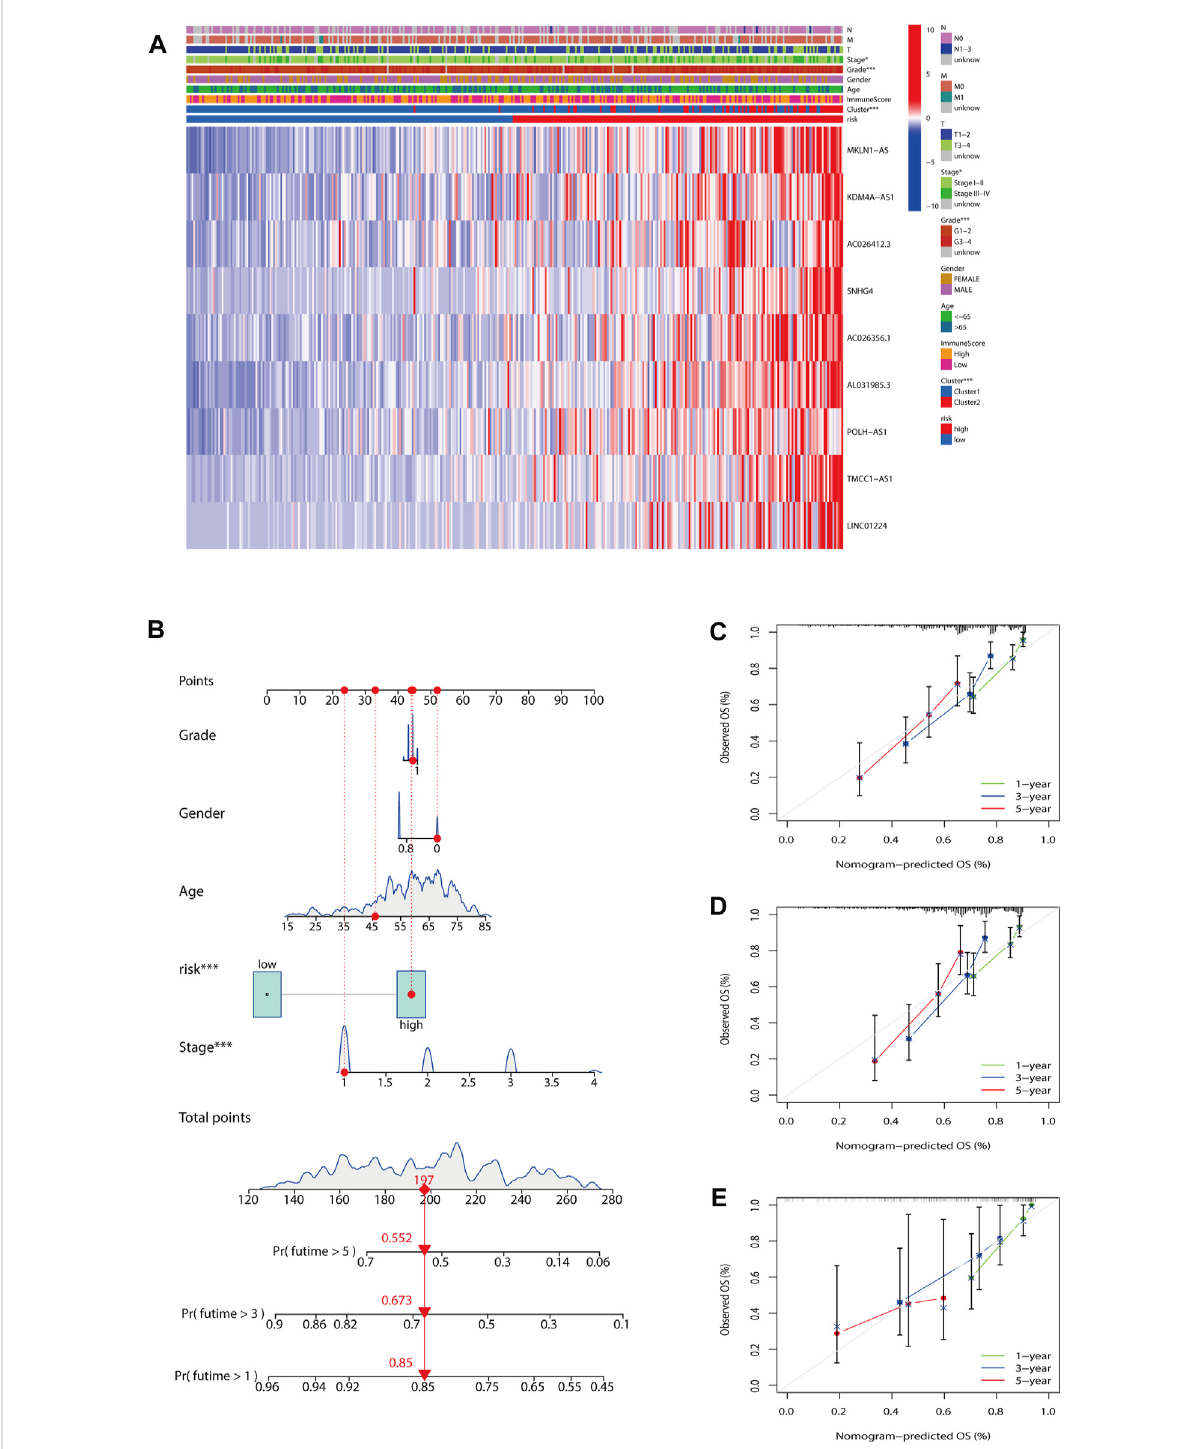
FIGURE 8 Establishment of nomogram. (A) The heatmap included the expression of nine m7G-LPS, clustering characteristics, immune score, and TMN stage. (B) Nomogrambasedongrade,gender,age,andriskscore. (C – E) Calibrationcurvesofthenomogramforpredictingandobserving1-,3-,and 5-years OS (* p < 0.05; *** p < 0.001). m7G-LPS, m7G-related lncRNA prognostic signature. m7G, N7-methylguanosine; lncRNAs, long non-coding